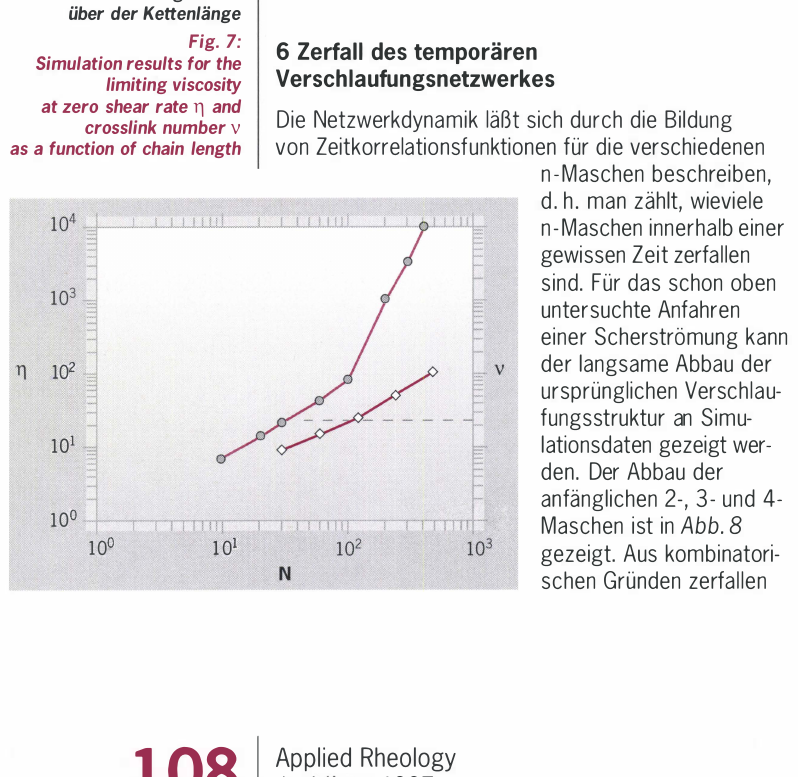
Fig. 7: Simulation results for the limiting viscosity at zero shear rate 11 and crosslink number v as a function of chain length